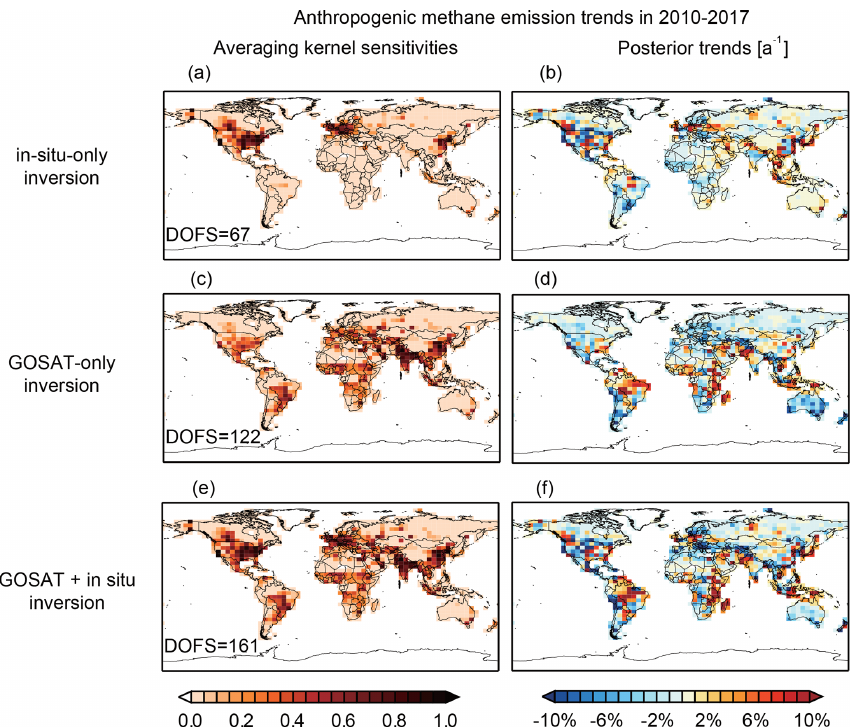
Figure 11. Same as Fig. 8 but for optimization of non-wetland (mainly anthropogenic) emission trends (%a − 1 ) in 2010–2017.